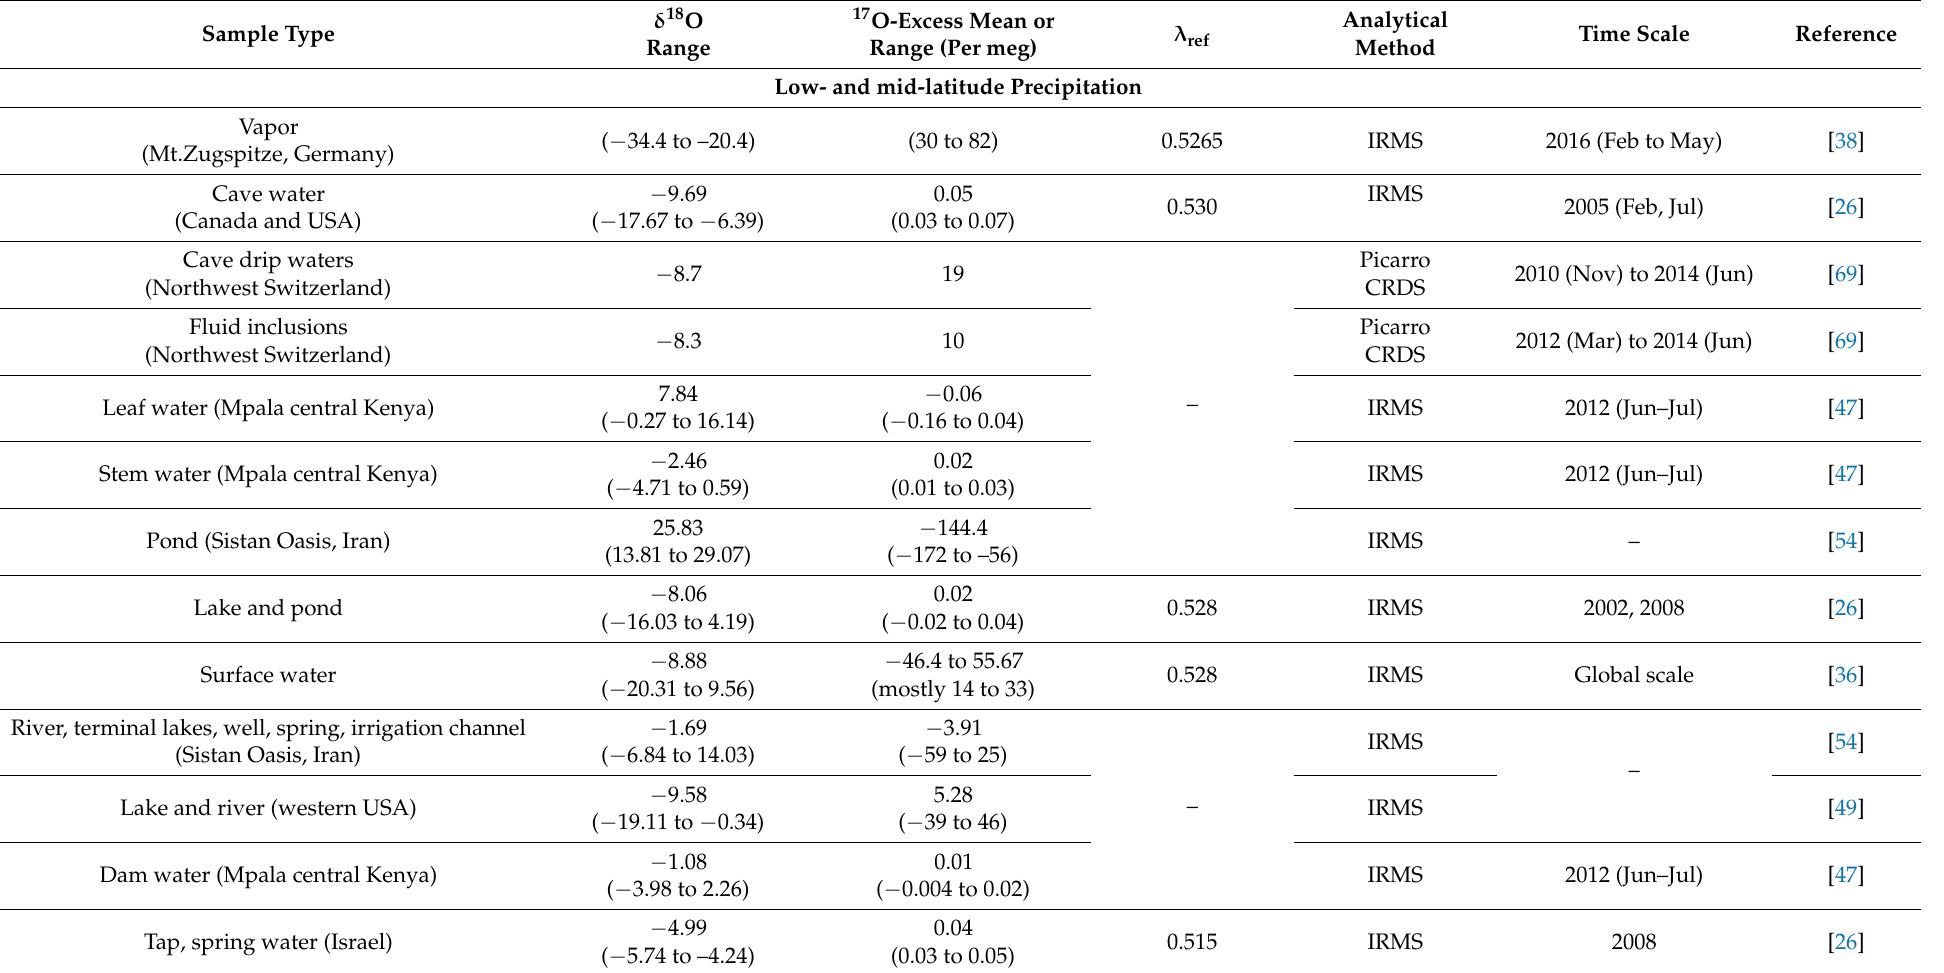
Table 2. Summary of published δ 18 O, λ ref and 17 O-excess in different samples. All values are averaged from published values. We note that the sampling location, period, and sampling numbers are distinct depending on the studies; thus, values are representative of local scale